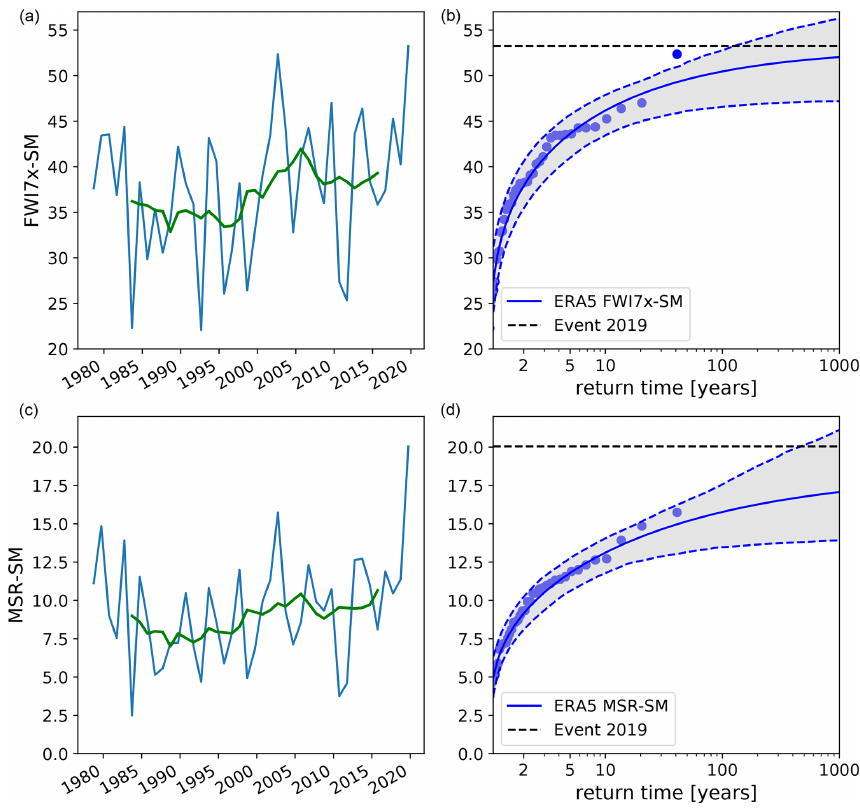
Figure 3. (a, c) Time series with the 10-year running mean of the area average of the highest 7d mean Fire Weather Index in September– February (a) and maximum of the monthly severity rating in September–February (c) . (b, d) Stationary GEV fit to these data; the dots represent the ordered years, and the grey bands represent the 95% uncertainty